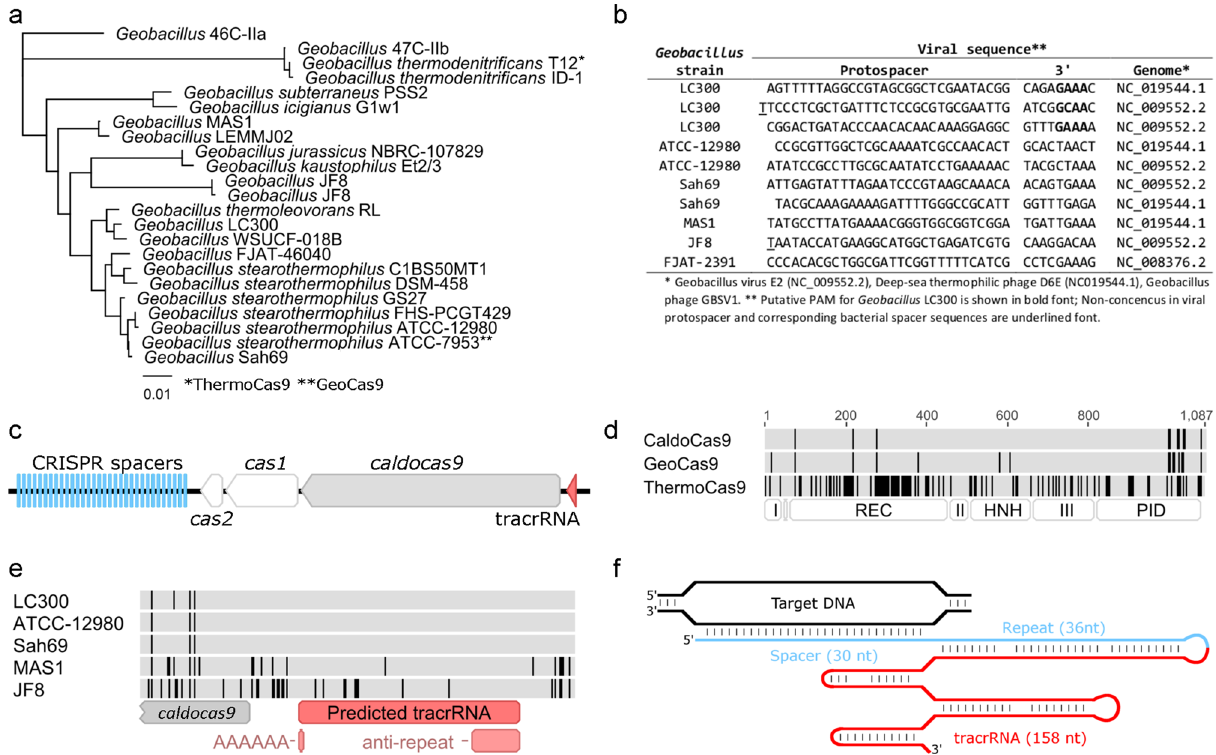
Figure 1. Identification of CaldoCas9 and design of gRNA. ( A ) Phylogeny of Cas9 enzymes identified in publicly available genomes of Geobacillus strains. Respective strain names are indicated. Scale bar indicates average number of amino acid residue substitutions per site. ( B ) A list of protospacers identified in viral genomes that are complimentary to spacers extracted from Geobacillus strains. Protospacer sequences and 9 bases downstream of the protospacer are shown. ( C ) A schematic illustrating organization of the CRISPR-Cas9 genomic region of Geobacillus strain LC300. The putative location of the tracrRNA is indicated, and of genes encoding Cas1, Cas2, and CaldoCas9. ( D ) Alignment of amino acid residue sequence of CaldoCas9 with the previously characterized enzymes GeoCas9 and ThermoCas9. Scale indicates polypeptide length. Each residue per enzyme is indicated in gray or black color, where gray indicates sequence consensus in all three enzymes, and black indicates non-consensus. At the bottom of the schematic, locations of Cas9 domains are indicated. ( E ) Genome sequence alignment of five Geobacillus strains, showing an approximately 0.3 kb region upstream of the caldocas9 open reading frame. Each nucleotide is indicated in gray or black color, where gray indicates consensus between sequences and black indicates non-consensus. Location of an CRISPR anti-repeat sequence, a poly-A sequence, and putative tracrRNA are indicated. ( F ) A schematic illustration of the designed gRNA. Predicted base-pairing is indicated with vertical black bars. The gRNA spans the entire sequence indicated in blue and